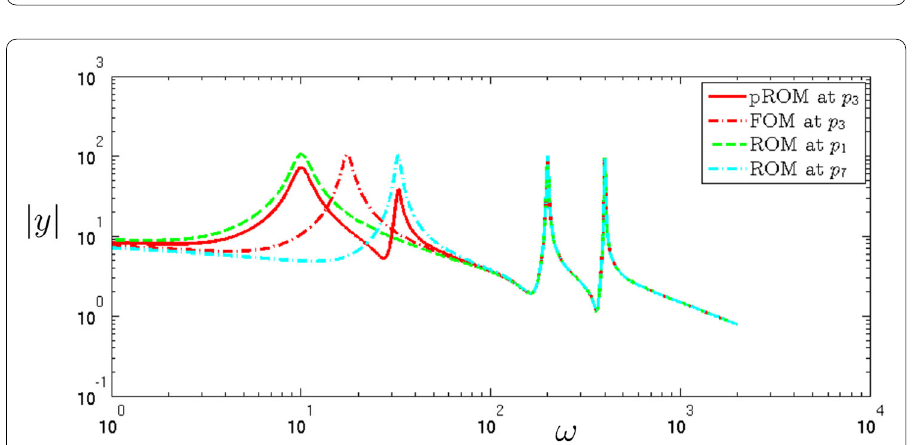
Fig. 9 Interpolating two ROMs built by the Loewner framework. The pROM is built by interpolating the ROMs built at p 1 and p